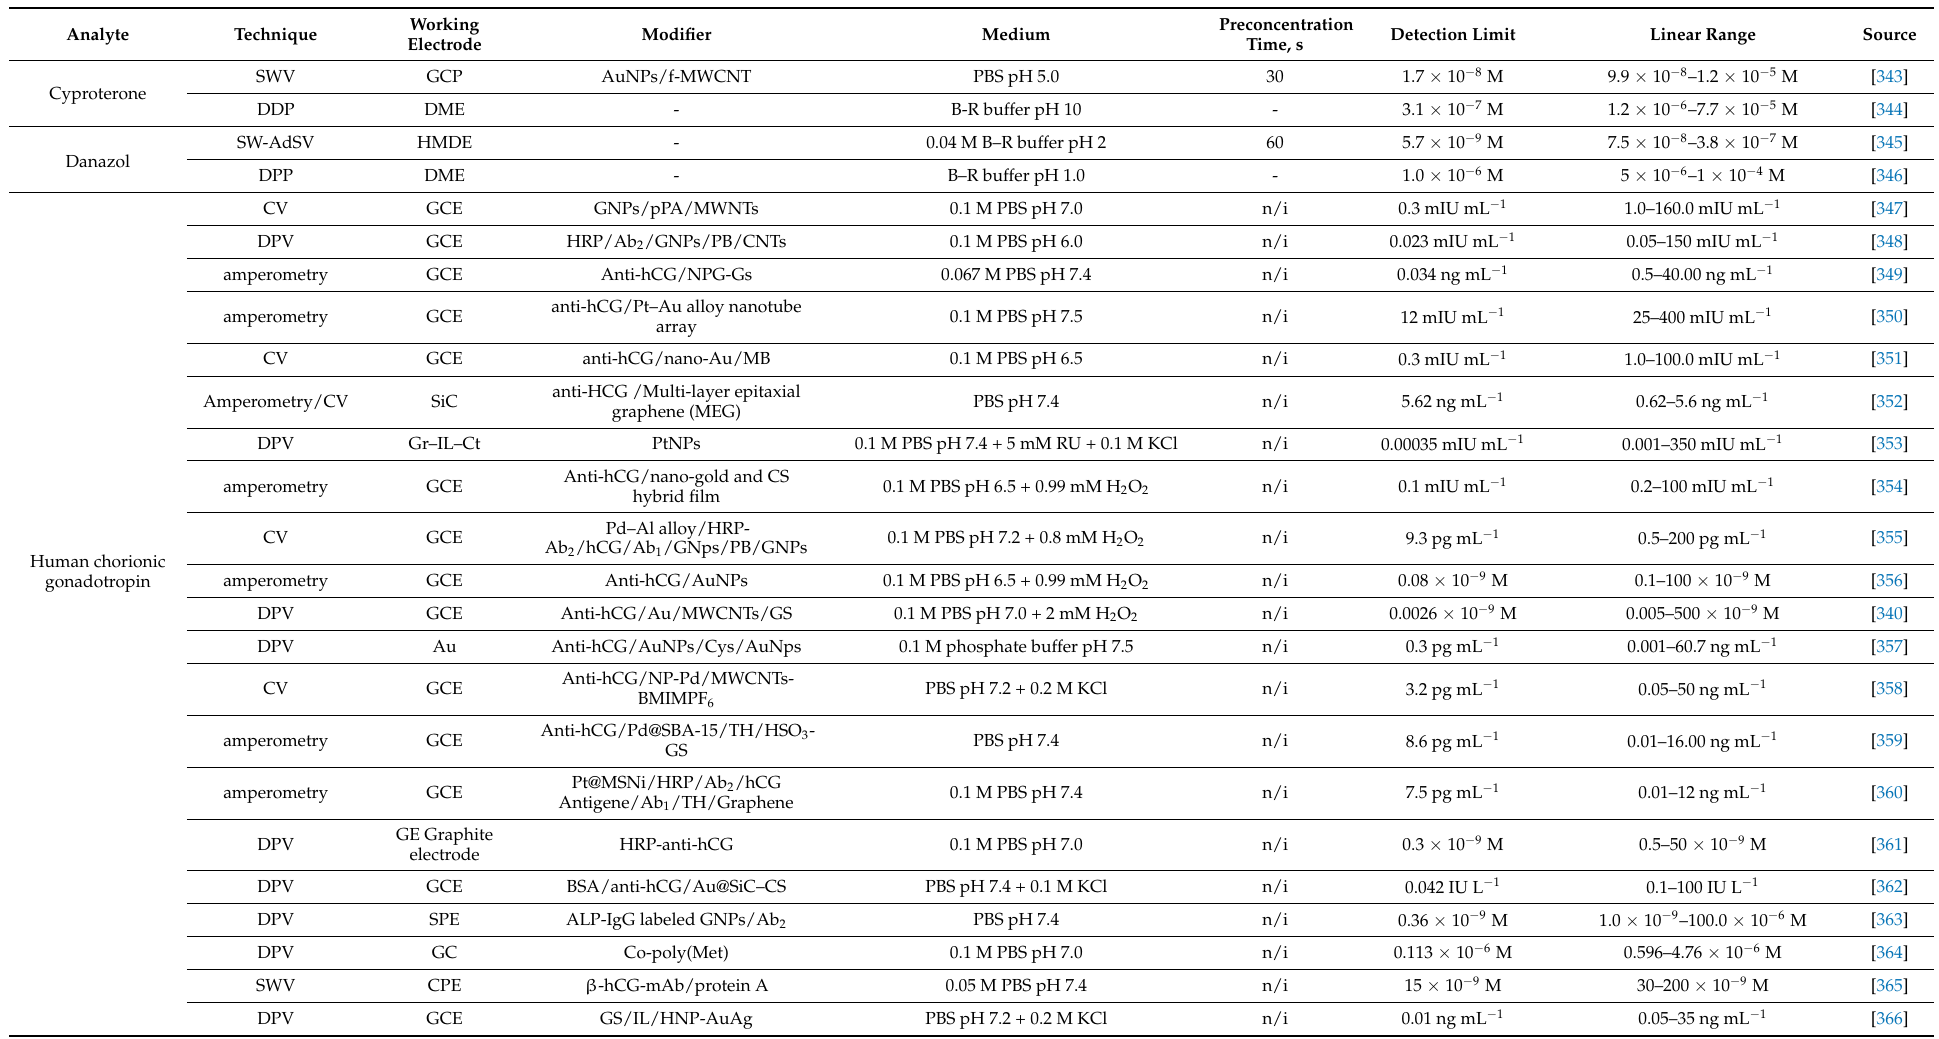
Table 7. Electrochemical methods of other hormones and steroid